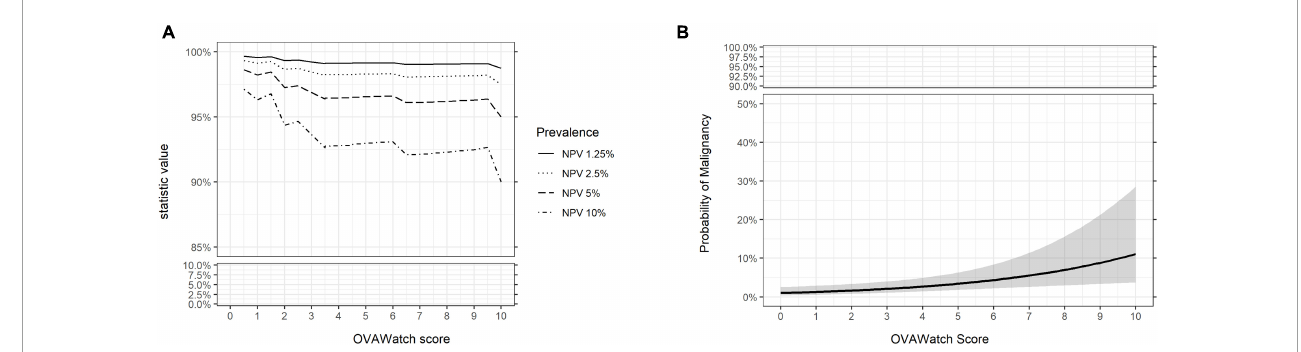
FIGURE7 Predicted performance of OVAWatch derived from the prospective real-world (PRW) dataset. (A) NPV is plotted as a function of OVAWatch cut-off score. Individual lines represent NPV over OVAWatch score cut-off by predicted prevalences from 1.25–10%. Note the y -axis break to emphasize the effects of prevalence on NPV. (B) Logistic regression of the probability of malignancy as a function of OVAWatch score.